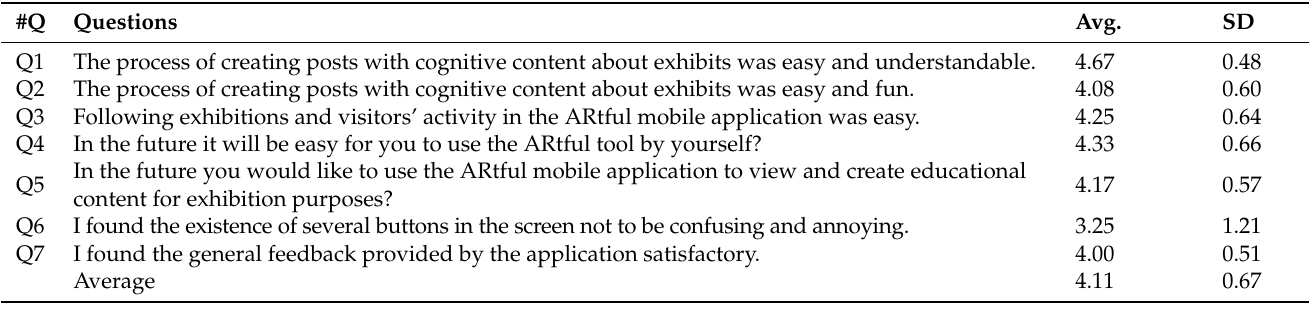
Table 6. Questions and average ratings of participants’ attitude concerning the usability of the ARtful mobile app.